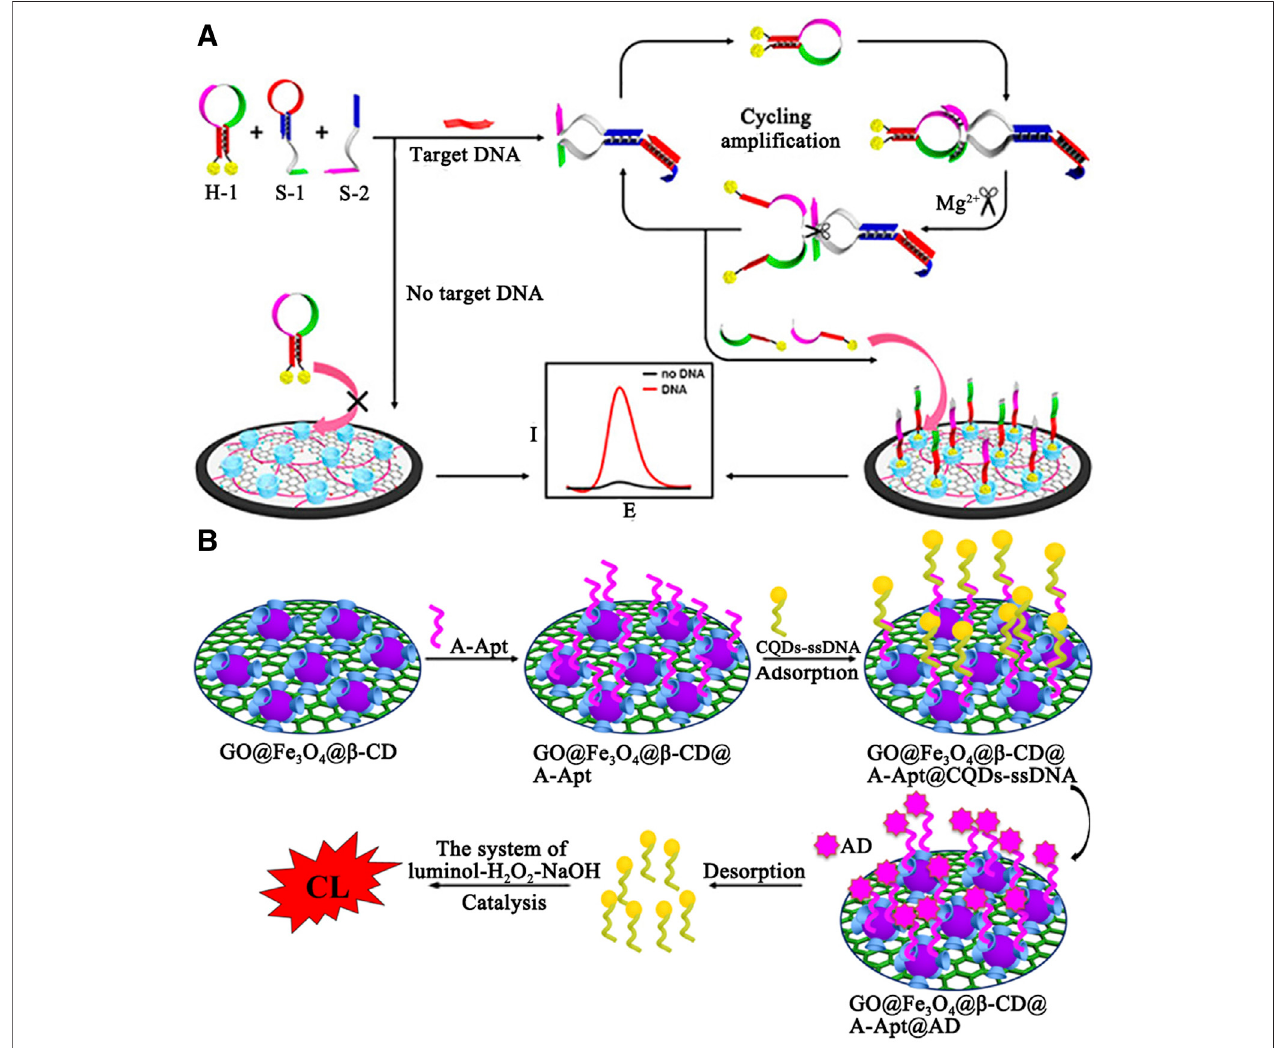
FIGURE 6 | (A) Illustration of the electrochemical DNA biosensor based on the host – guest interaction and Mg 2+ -assistant DNA recycling. (B) The schematic diagram construction of GO@Fe3O4@ β -CD@A-Apt/CQDs-ssDNA-CL biosensor.